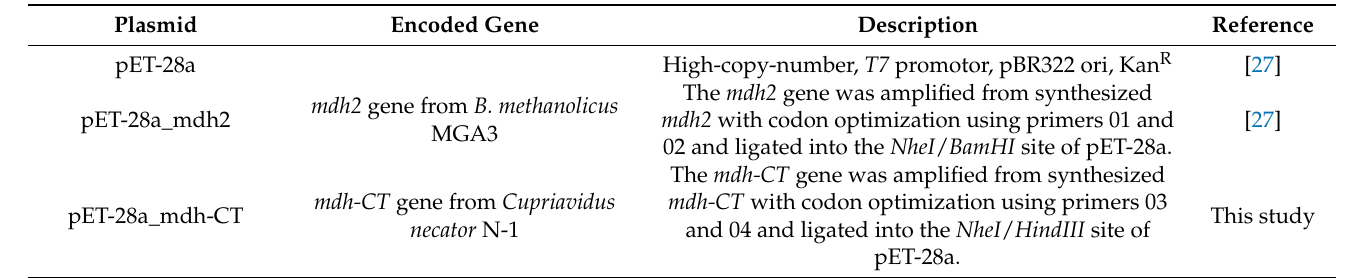
Table 1. Plasmids used in this study. The first and second columns contain the plasmids and genes used in this study, respectively. The third column contains the plasmid